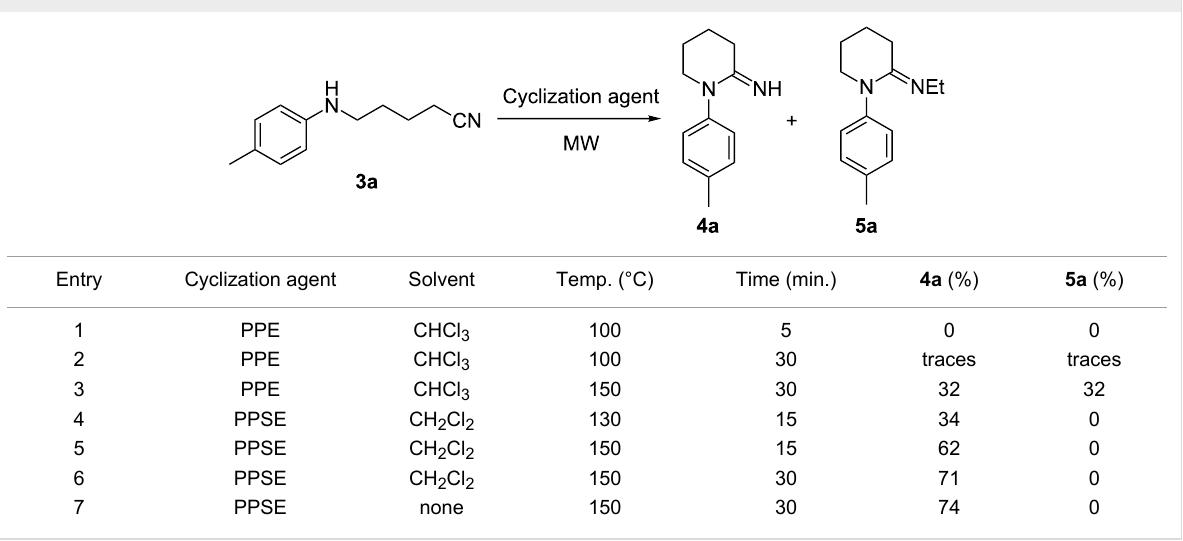
Table 2: Reaction conditions screening for 1-( p -tolyl)-2-iminopiperidine ( 4a ).